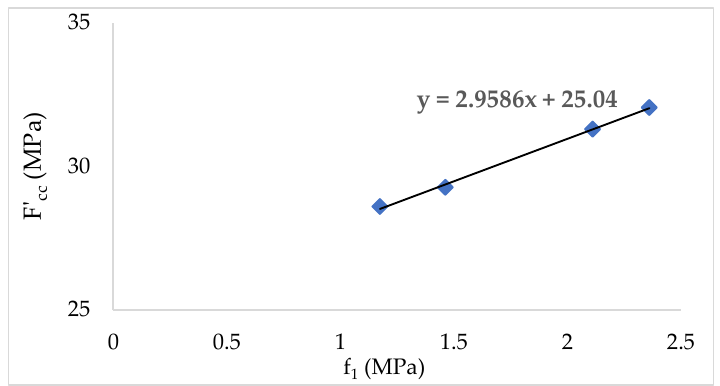
Figure 14. Peak compressive strength vs. lateral confining pressure. Table 6. Comparison of experimental and analytical confined compressive strength.